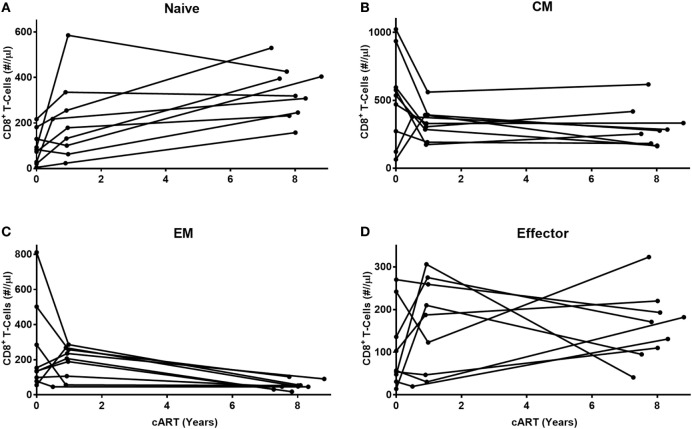
Early and late effects of combination anti-retroviral treatment (cART) on CD8+ T-cell numbers. Longitudinal analysis of cell numbers in four CD8+ T-cell subsets [(A) naïve, (B) central memory (CM), (C) effector memory (EM), and (D) effector] of nine HIV-infected individuals, during the first year of cART until at least 7 years of cART. Because of low sample sizes, we refrained from testing these changes statistically.